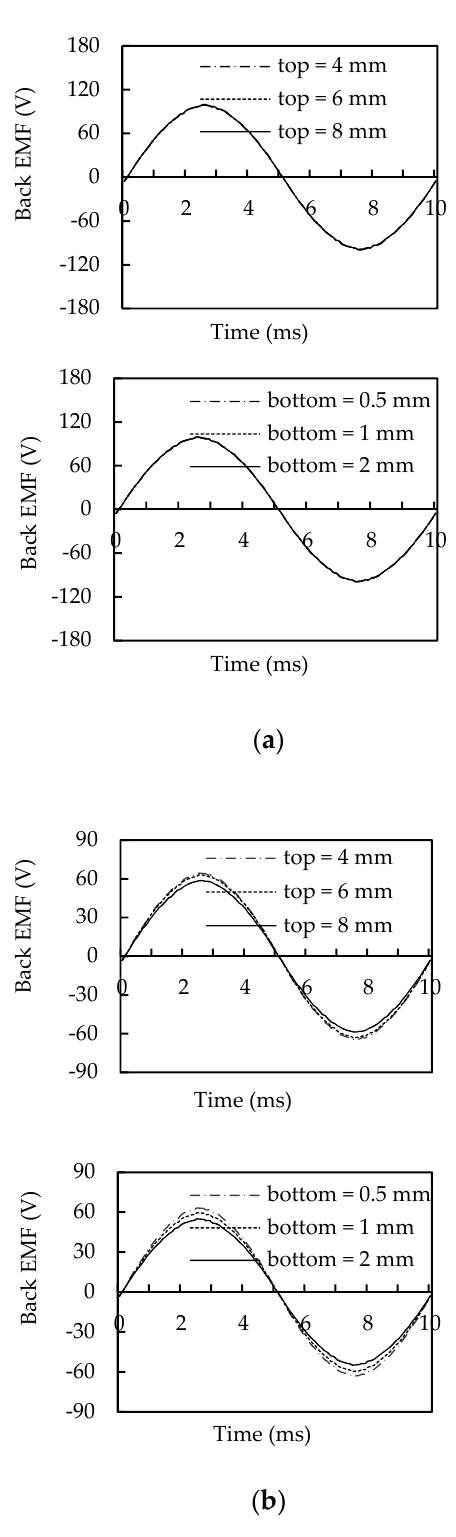
Figure 21. The no-load back EMF with different top and bottom widths of the NMC ( n = 1500 r/min): ( a ) s = 11 mm; ( b ) s = 0 mm.